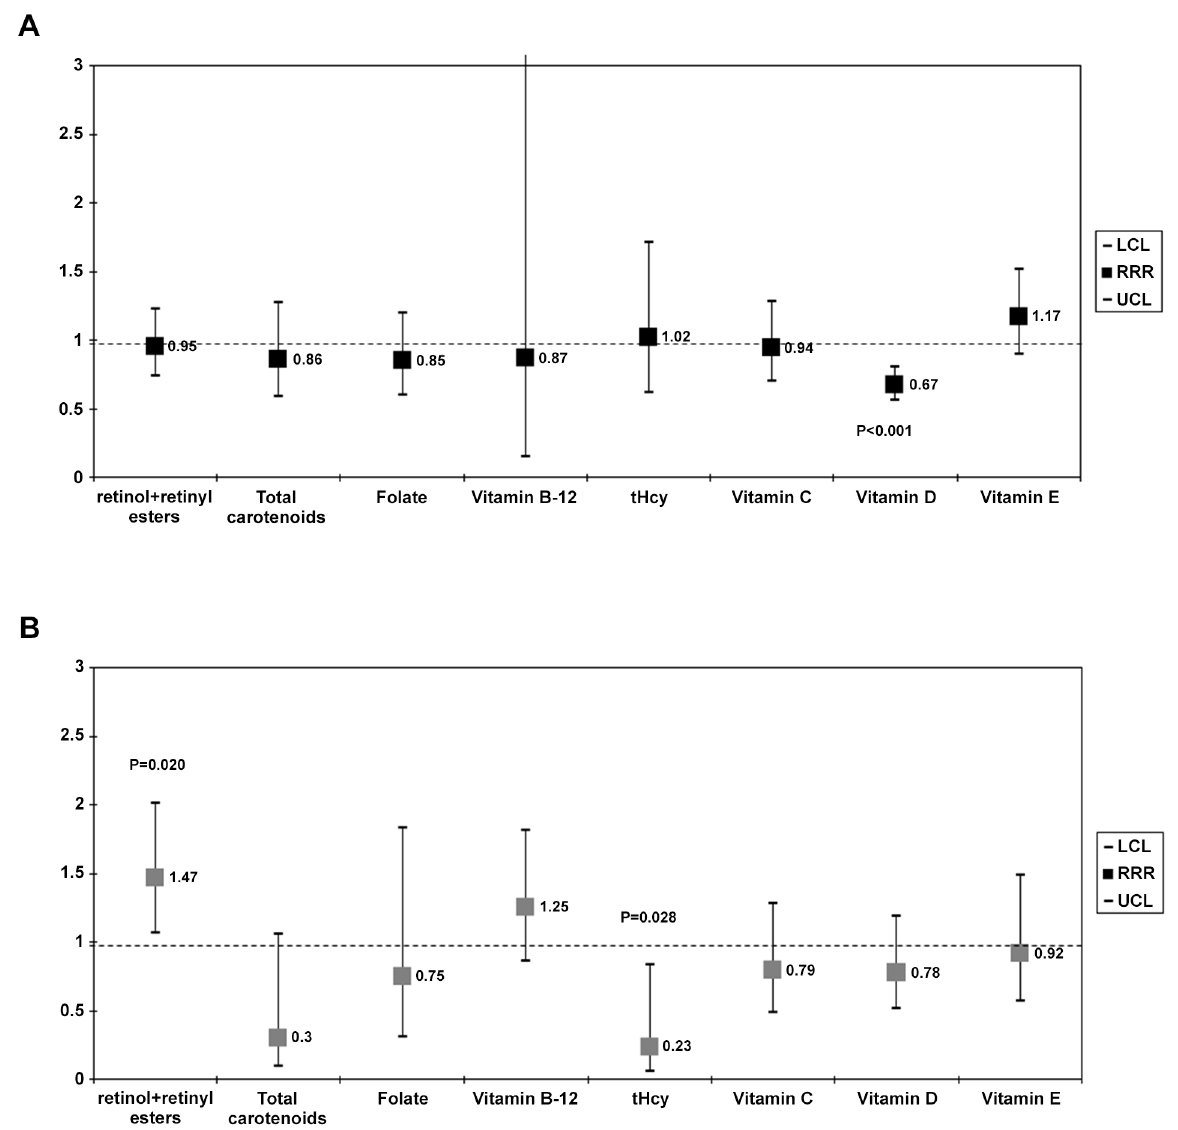
Figure 1. Relative risk ratio (RRR with 95% CI) per 1 SD nutritional biomarker: (A) Insomnia vs. Normal sleep duration a,b , (B) Other sleep disorder categories vs. None a,b . Abbreviations : BMI=Body Mass Index; CI=confidence interval; Met=Metabolic Equivalent; n-3 HUFA=omega-3 highly unsaturated fatty acids; NHANES=National Health and Nutrition Examination Survey; RRR=relative risk ratio; SEE=Standard error of the estimate. a Values are Relative Risk Ratios (RRR) with 95% confidence intervals. Sampling design complexity is taken into account in all analyses. b Models included all serum nutritional biomarker exposures simultaneously, and adjusted for socio-demographic factors: age, sex, race/ ethnicity, marital status, educational level and poverty income ratio, and other potential confounders: Lifestyle and health-related factors (smoking status, BMI, physical activity: Mets.hr.wk 2 1 , history of selected chronic conditions (i.e. type 2 diabetes, CVD and cancer)), anti-depressant use and dietary intakes (total energy intake, alcohol, caffeine, fiber, n -3 HUFA, each of the five carotenoids, vitamin C, vitamin E, folate, vitamin B-12), fruit and vegetable intake, supplement use, anti-depressant use, and the inverse mills ratio, 2-stage Heckman selection model as well as serum cholesterol (See Table 4, Model 4 for more details).